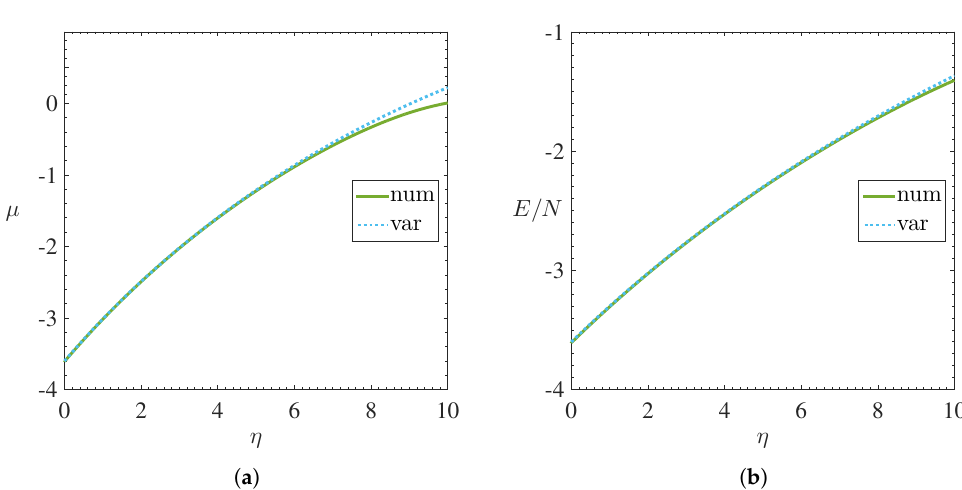
Figure 1. Numerical and variational results illustrating the behavior of ( a ) chemical potential µ and ( b ) energy per magnon E / N as a function of the nonlinearity coefficient η . Solid lines represent numerical solutions while dotted lines represent variational solutions. Stability was confirmed by the anti-VK criterion ( d µ / dN > 0) observed in ( a ).